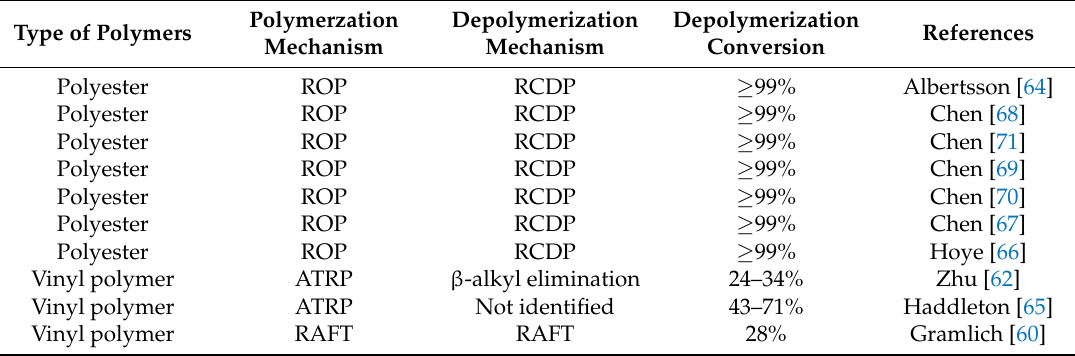
Table 1. Summary of reversible polymerization approaches in this perspective. Type of